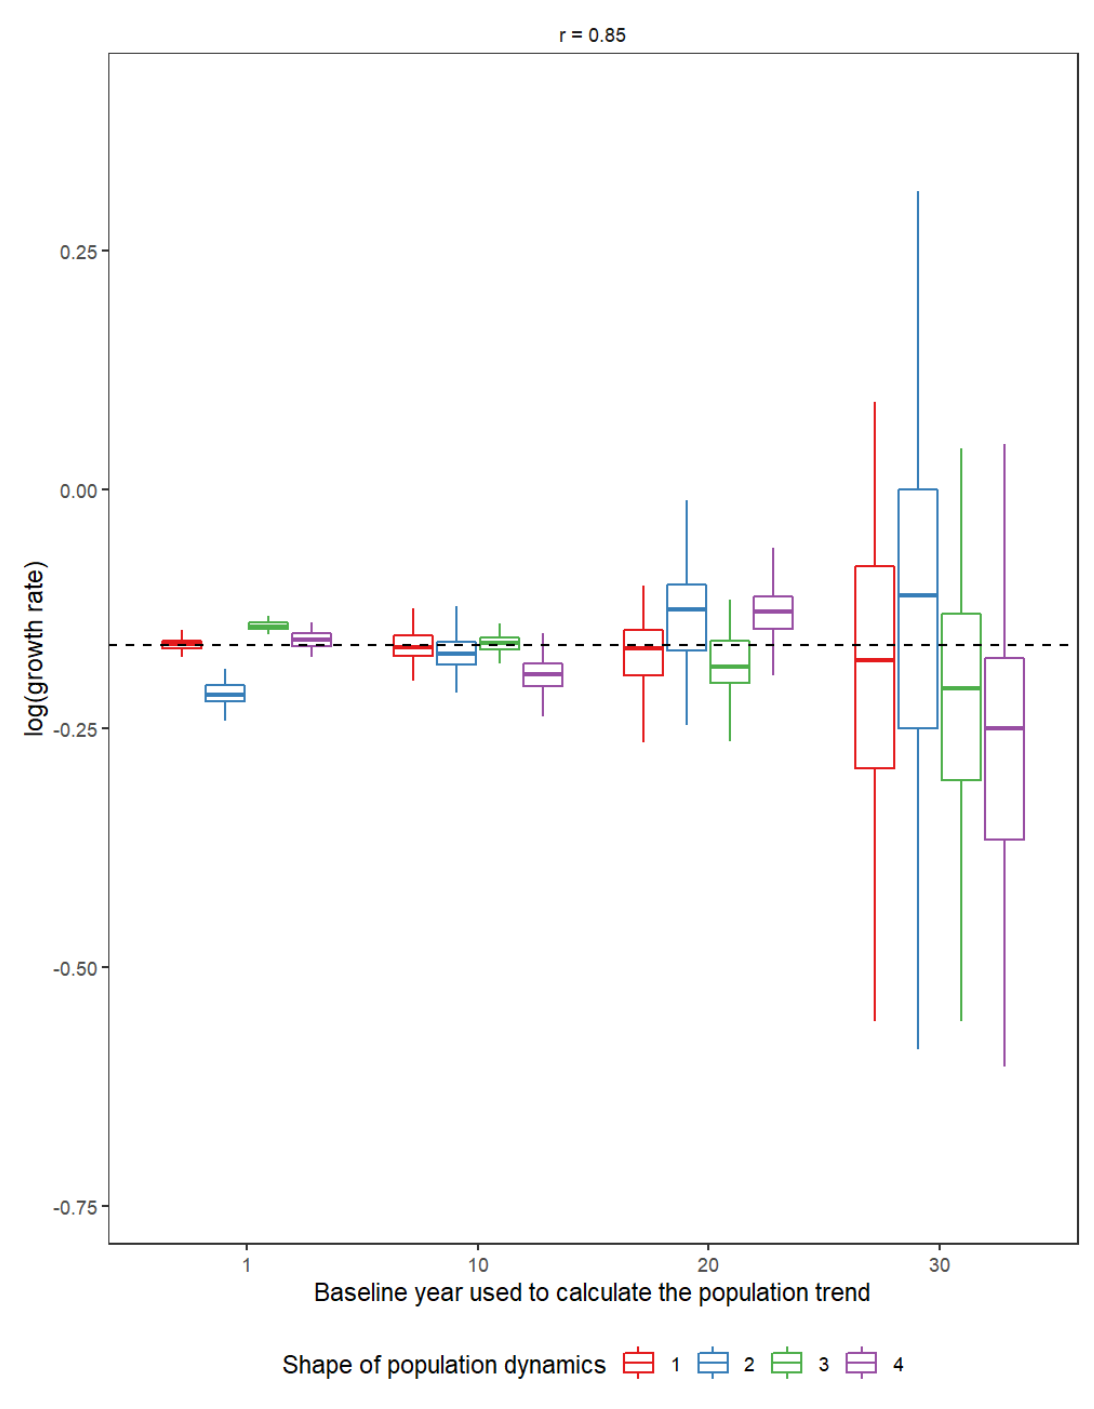
Figure S7: Estimated growth rate when a decline of 15%/year is simulated. This is the same plot than in the left panel of Figure 4d, but without the outliers to improve readability of average biases. The dashed horizontal line shows the value of the logarithm of the true (simulated) growth